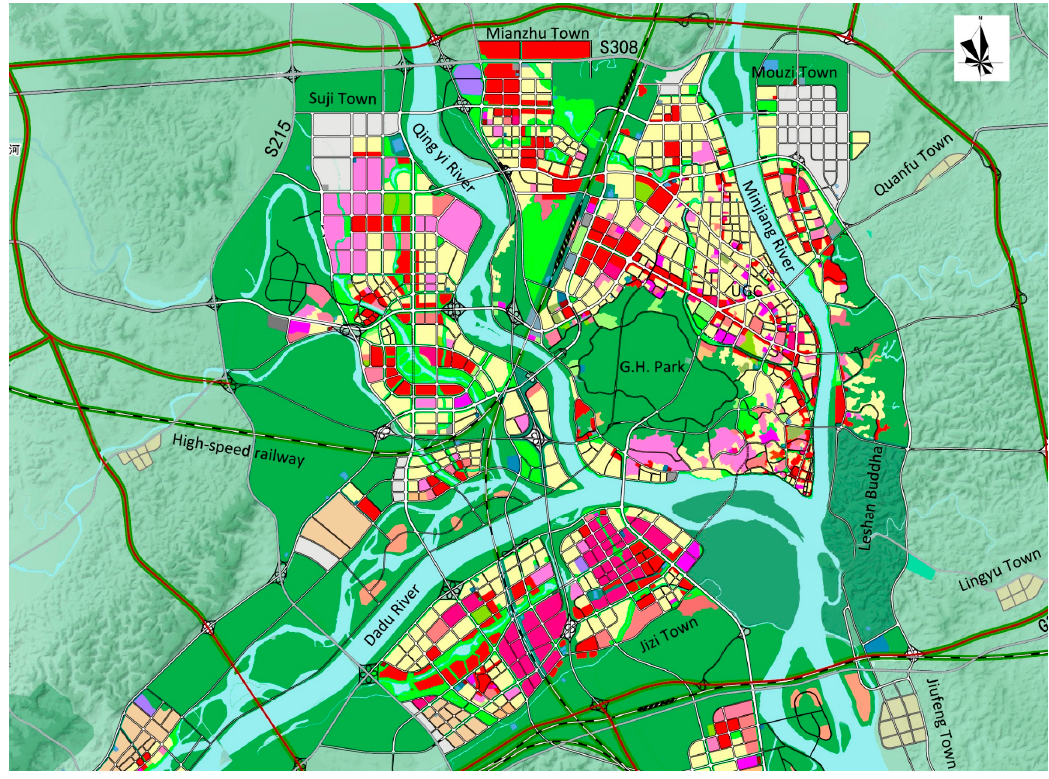
Figure 12. Urban planning map of LS from 2018 to 2030 (2017 version, LS government).